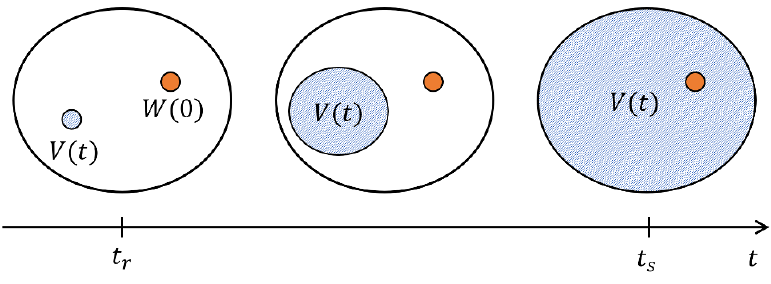
Figure 1 . A cartoon of scrambling. The operator V ( t ) expands in the space of degrees of freedom. t r is relaxation time, and t s is the scrambling time when V ( t ) is essentially scrambled among all degrees of